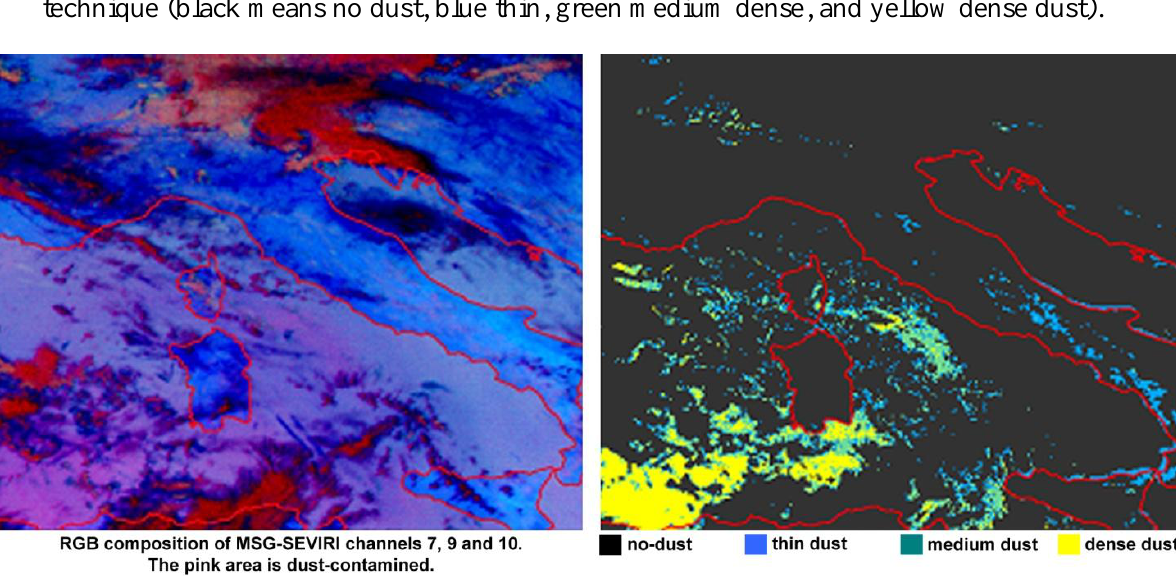
Figure 1. RGB and dust detection technique for image at 2011-09-01 10:45 GMT. Left: 10.8 µm, 8.7 µm and 12.0 µm RGB composition. Right: results of the dust detection technique (black means no dust, blue thin, green medium dense, and yellow dense